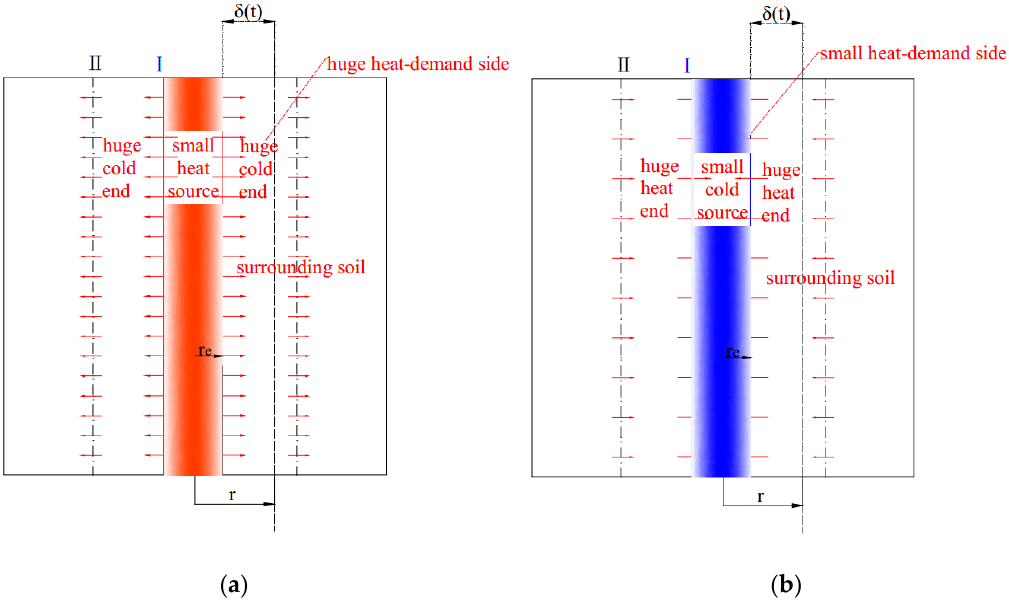
Figure 12. The heat transfer mechanism during the operation of the GSHP system: ( a ) summer case; ( b ) winter